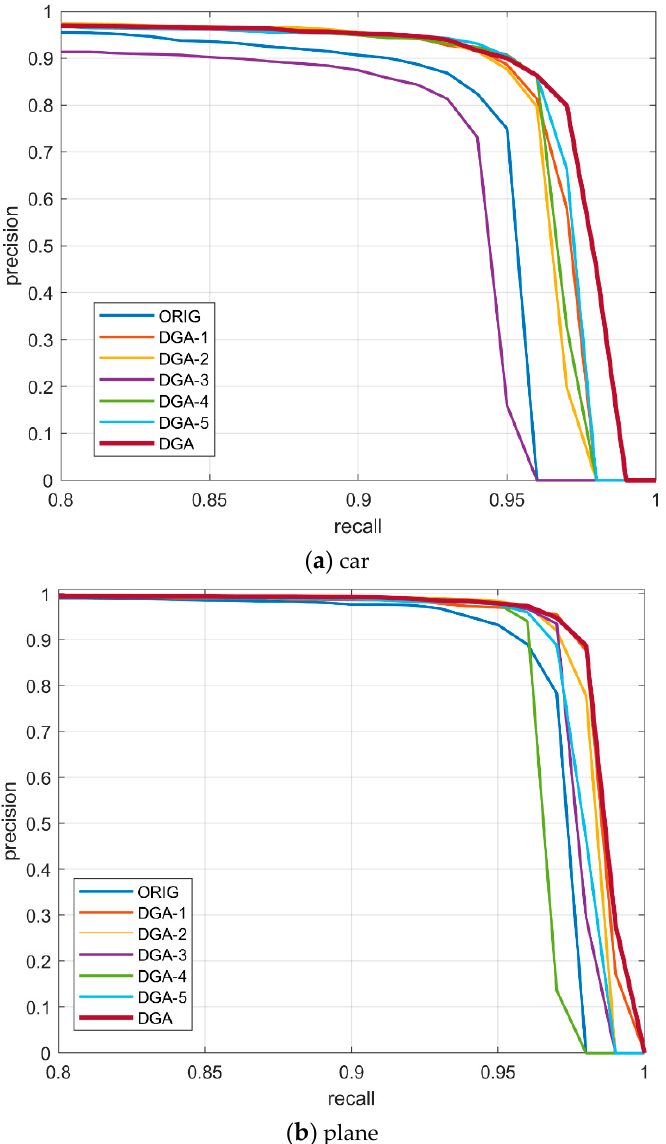
Figure 5. Precision-recall curves of different classification networks used on the UCAS-AOD dataset.